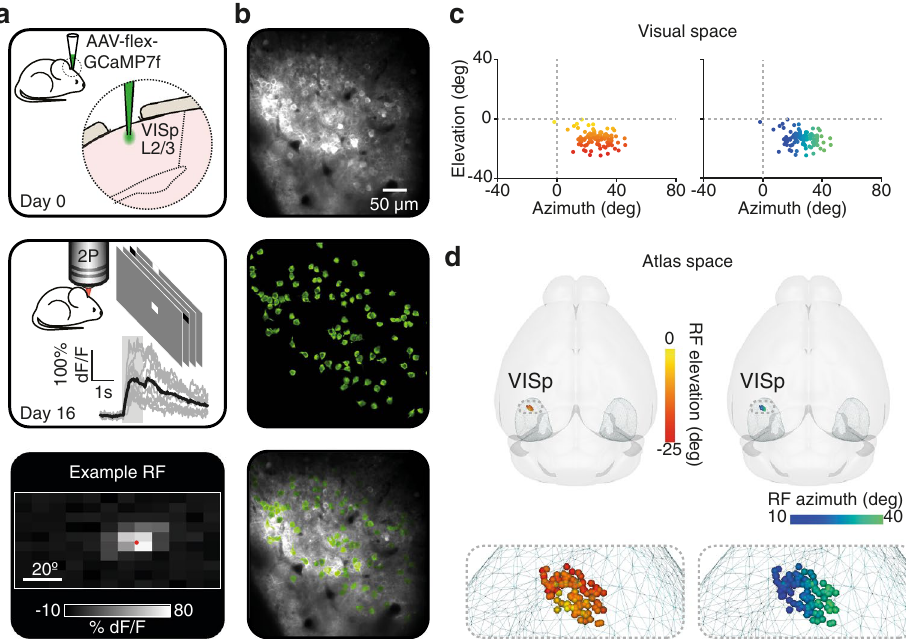
Figure 3. Localization of recorded cell populations according to the centroid of the labeled volume . ( a ) Schematic of the functional imaging experiment timeline. Top: Injection of an AAV carrying the fluorescent indicator GCaMP7f in the primary visual cortex (VISp) at a depth of 250 μm (layer 2/3, L2/3). Middle: Two- Photon calcium imaging of L2/3 neurons in awake head-fixed mice, while presenting sparse noise stimuli. Example recorded trials from one neuron are shown in grey and their average response in black, aligned to the onset of stimulus (shaded grey area). Bottom: Average Receptive Field (RF) from one neuron, shown in visual space. ( b ) Top: two-photon grayscale image of GCaMP7f-expressing cells. Middle: Regions Of Interest (ROIs, green) determined by automated detection of labeled cells using suite2p. Bottom: Overlay of the Two-Photon image (grayscale) and the ROIs (green). ( c ) Left: centroids of all RFs recorded in one animal, color-coded according to their elevation in visual space. Right: centroids of all RFs recorded in one animal, color-coded according to their azimuth position in visual space. ( d ) Left: rendering of the position in atlas space of all recorded cells shown in panel c, color-coded according to their elevation in visual space. Right: rendering of the position in atlas space of all recorded cells shown in panel c, color-coded according to their azimuth position in visual